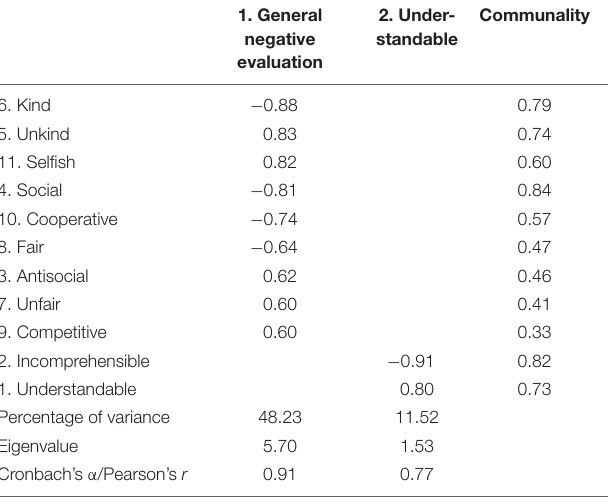
TABLE 5 | Factor loadings based on an exploratory factor analysis with a principal axis factoring and direct oblimin rotation on 11 evaluation items ( N = 140).